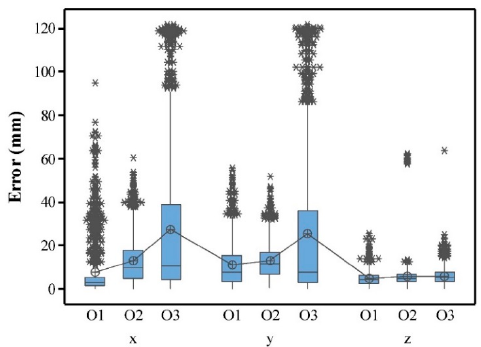
Figure 5. Boxplot of measurement errors in three directions ( x , y , and z ). In each dimension, the box of each object shape shows errors obtained from three replicates (for example, O1_1, O1_2, O1_3) of a shape under all 17 POU s. The circle with a plus sign in each box is the mean of this group. Asterisks above the boxes are outliers in